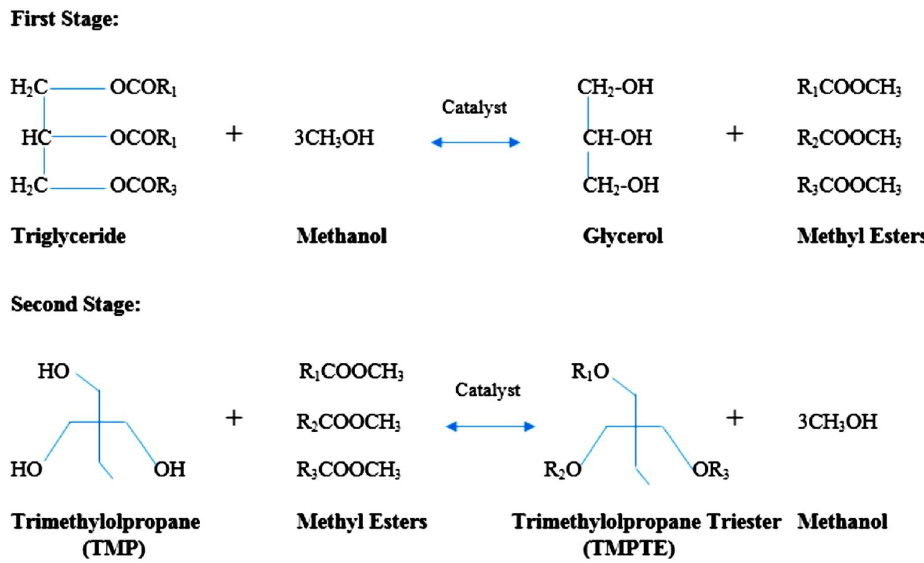
Figure 3. Stages of bio-lubricant production by transesterification